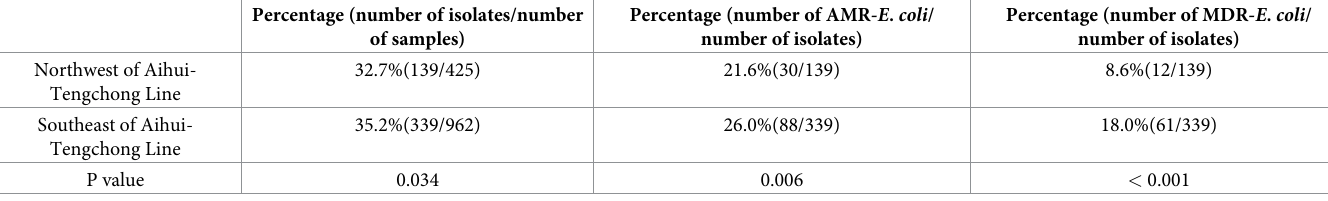
Table 4. Statistic analysis of isolation rate and drug resistance rate among E . coli isolates from different regions. Percentage (number of isolates/number Percentage (number of AMR- E . coli / Percentage (number of MDR- E . coli / of samples) number of isolates) number of